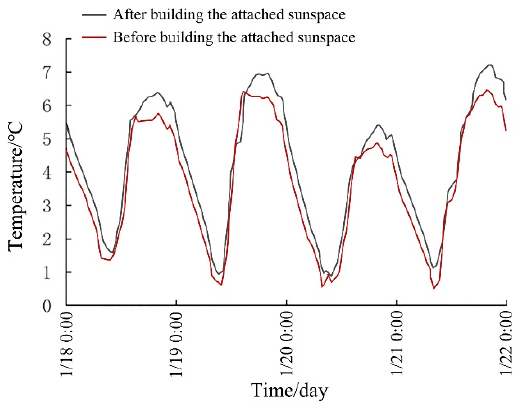
Figure 14. The simulated temperature of the master bedroom before and after building the sunspace.